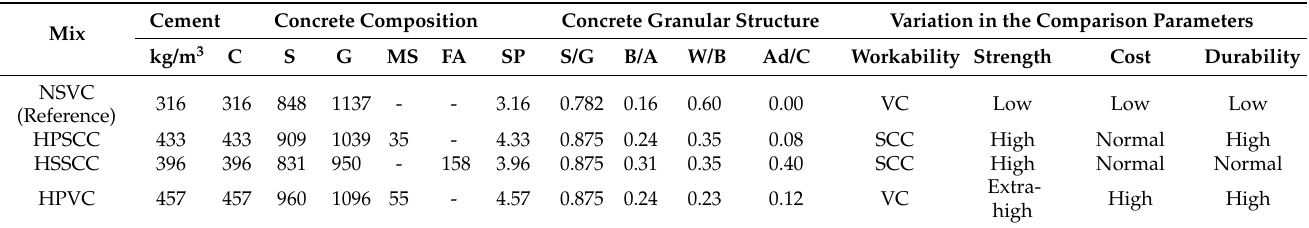
Table 3. Mix proportions and compositions for the concrete